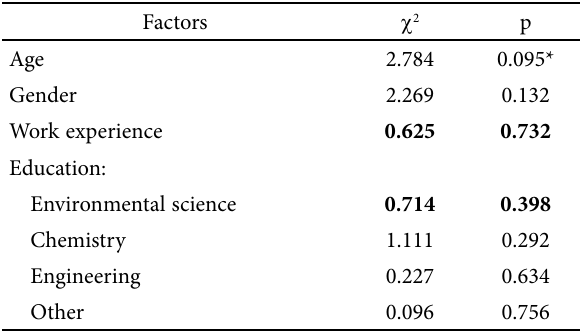
Table 1. Factors influencing the variety of environmental components covered in EIA. Survey results: the EIA